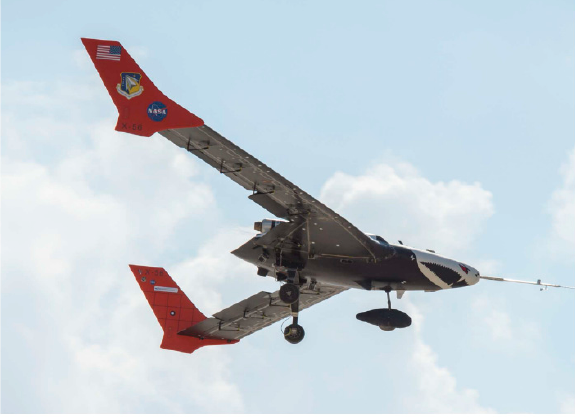
Figure 4. Performance test of fiber optic sensing system (FOSS) on X56 [3].